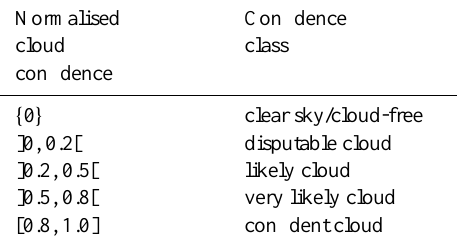
Table 3. Definition of cloud confidence classes.